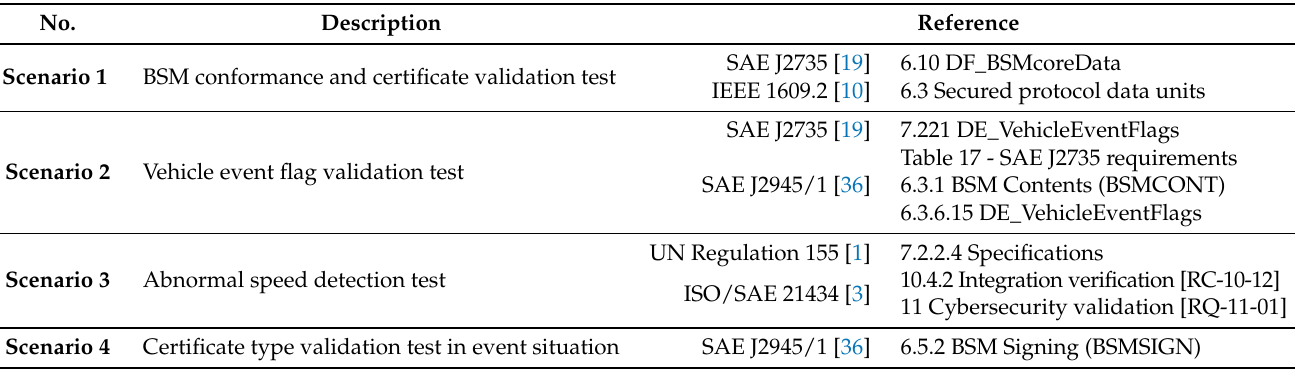
Table 3. Description of proposed scenarios.